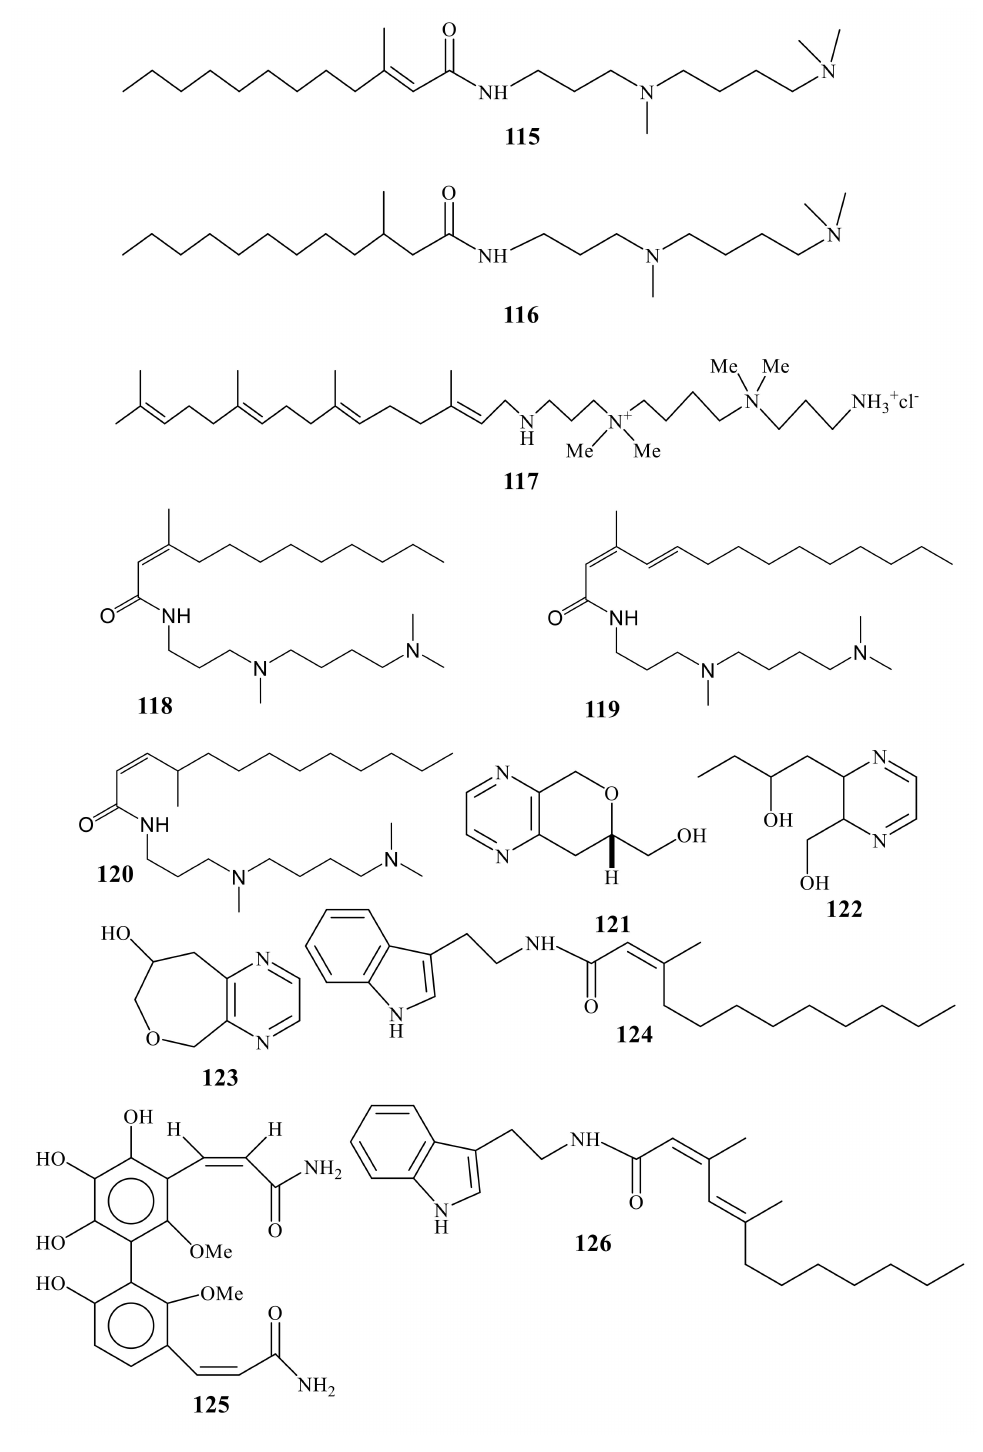
Figure 10. Spermidines